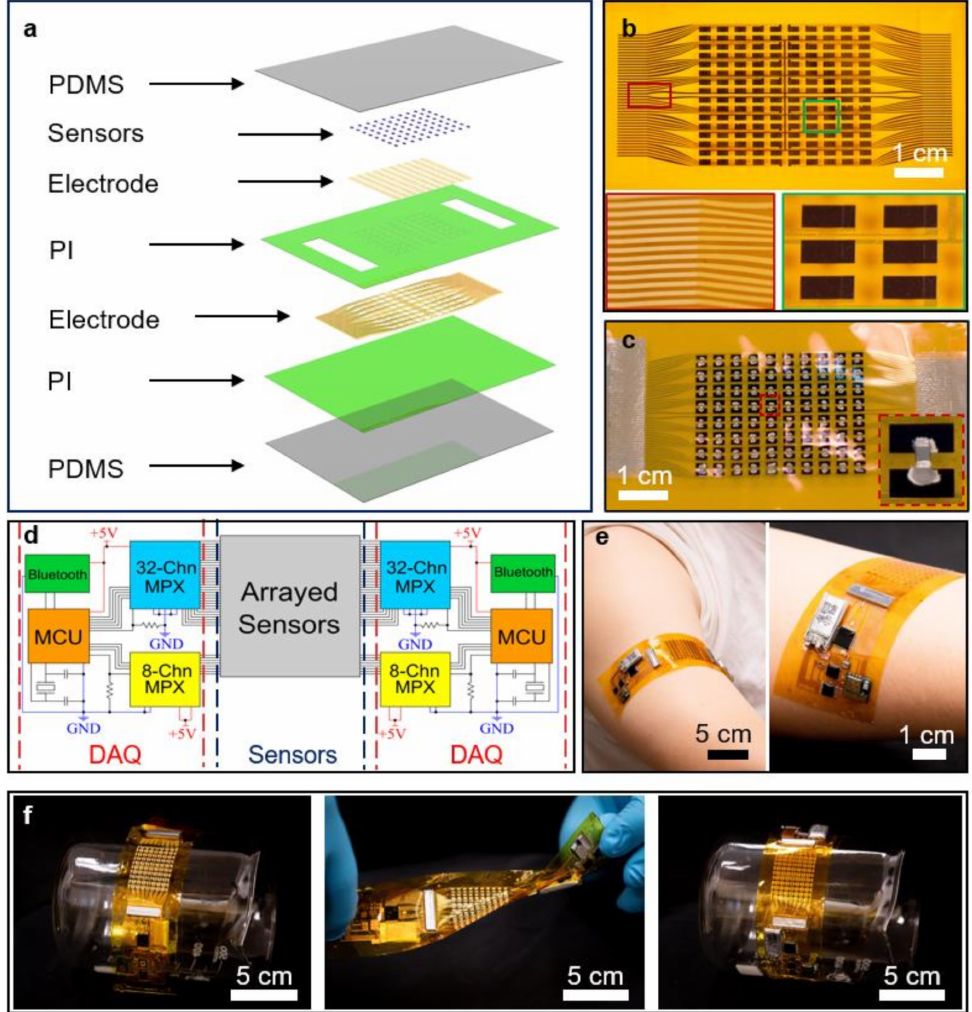
Figure 1. Overview of the WH-sensor. ( a ) Schematic illustration of the sensing panel of the WH- sensor. ( b ) Optical images of the sensing panel of the device with enlarged regions of conductive patterns. ( c ) Optical images of the sensing panel of the device with enlarged regions of soldered sensors. ( d ) Equivalent circuit diagram of the WH-sensor. ( e ) Optical images of the device attached to the right arm of a volunteer during operation. ( f ) Optical images of the device under bending inward, twisting, and bending